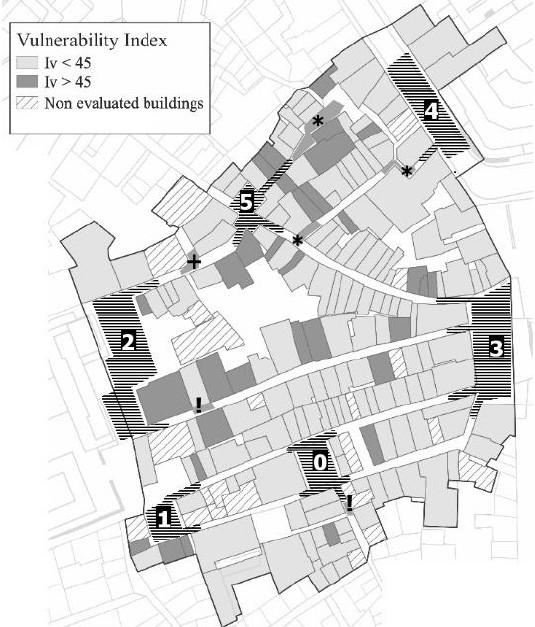
Figure 7. Open spaces usage at the end of the simulation in the SCENARIO B, by evidencing: assembly areas used by more than the 10% of arrived evacuees, and related access (dashed areas); main areas of spontaneously gathering with different marks to compare with the SCENARIO A results in Figure 3 (grey areas along the streets marked by *: similar position; +: placed near to a deleted assembly area; !: close to a new assembly area).